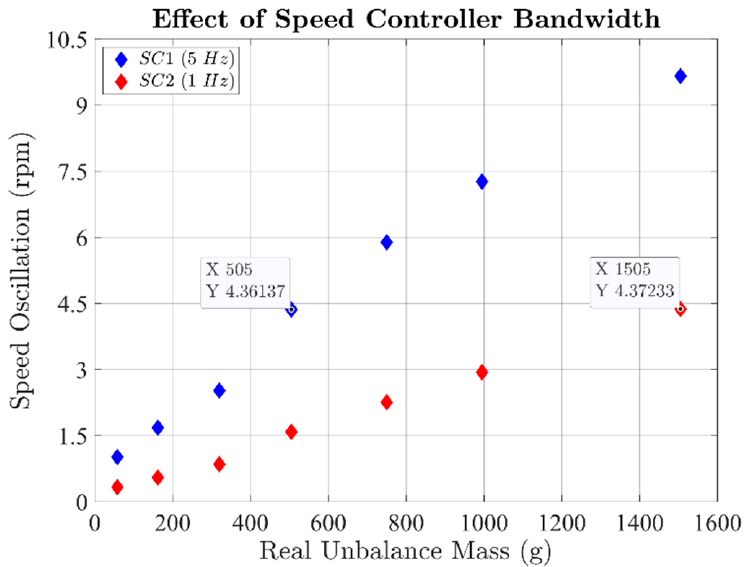
Figure 6. Conventional method: effect of the speed controller bandwidth on the speed oscillations for a given unbalance mass.